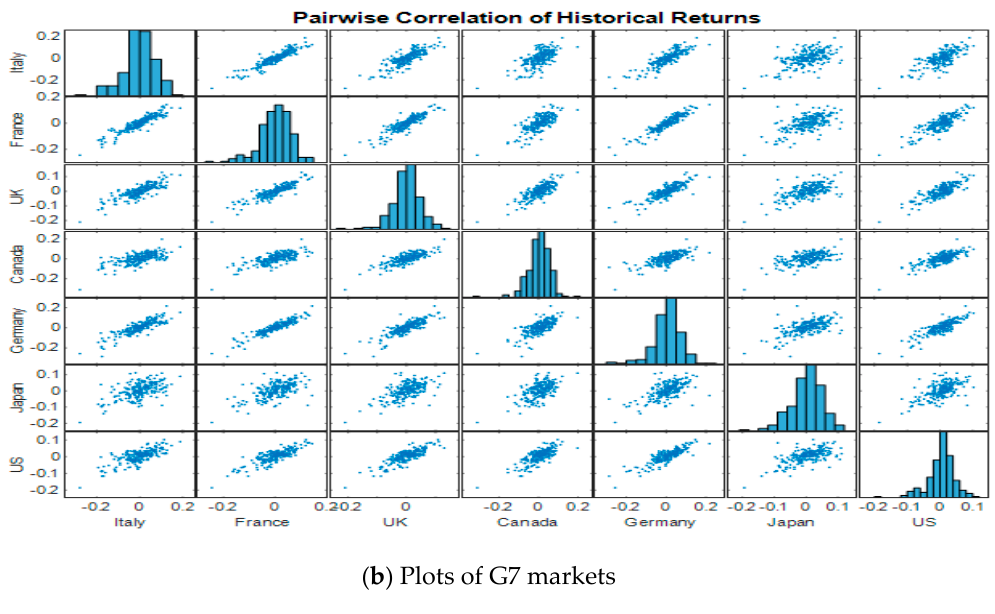
( b ) Plots of G7 markets Figure 2. Pairwise correlation of historical returns. Figure 2. Pairwise correlation of historical returns.